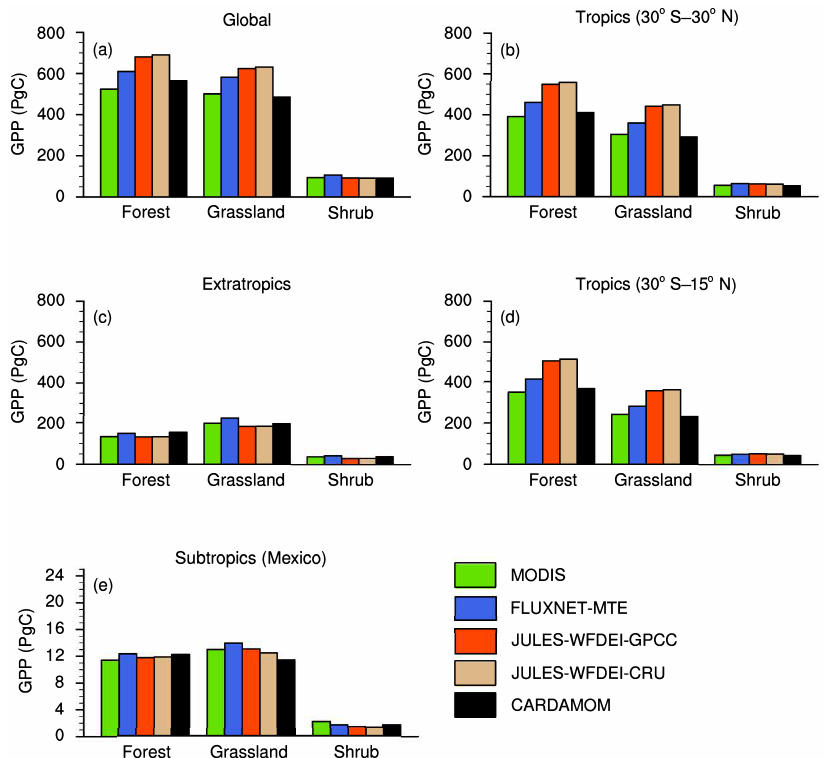
Figure 4. Total (summed over 10 years) model-simulated (JULES-WFDEI-GPCC, JULES-WFDEI-CRU and CARDAMOM), observation- based (FLUXNET-MTE and MODIS) GPP fluxes for the 2001–2010 period on global and regional scales (tropics, subtropics and extratrop- ics) for three biome types (forest, grassland and shrub). Panel (a) shows the global total annual GPP, (b) for the tropics (30 ◦ S–30 ◦ N), (c) the extratropics (30–90 ◦ N and 30–90 ◦ S), (d) the tropics at 30 ◦ S–15 ◦ N and (e) the subtropics at 15–30 ◦ N for forests, grasslands and